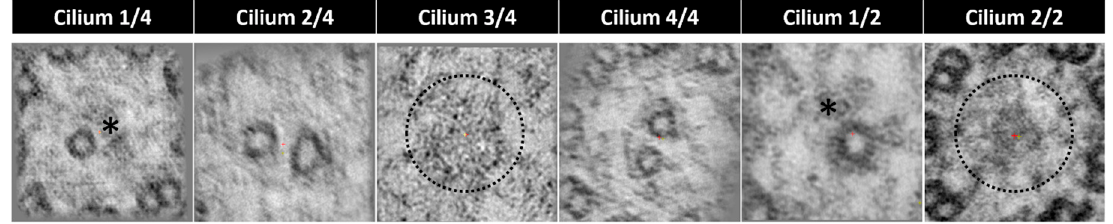
Figure 7. Tomogram z-projection confirms central pair heterogeneity. CPs from two different LROs (n = 2) and from six different cilia, showing variation in the presence of the CP. Cilium 1/4 and 1/2 showing only one tubule present, cilium 2/4 and 4/4 showing both tubules present and cilium 3/4 and 2/2 showing no tubules in the central pair region. * missing tubule, incomplete CP; dotted circle missing CP. Bar 50 nm.